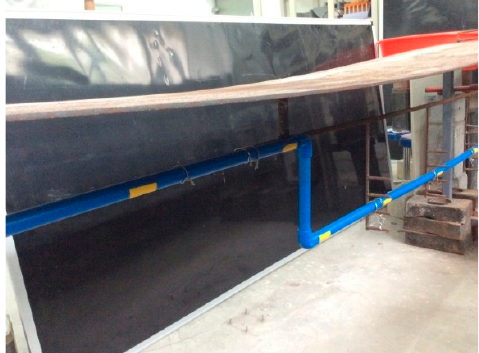
Figure 11. The test model and step-type LLSS in the laboratory.